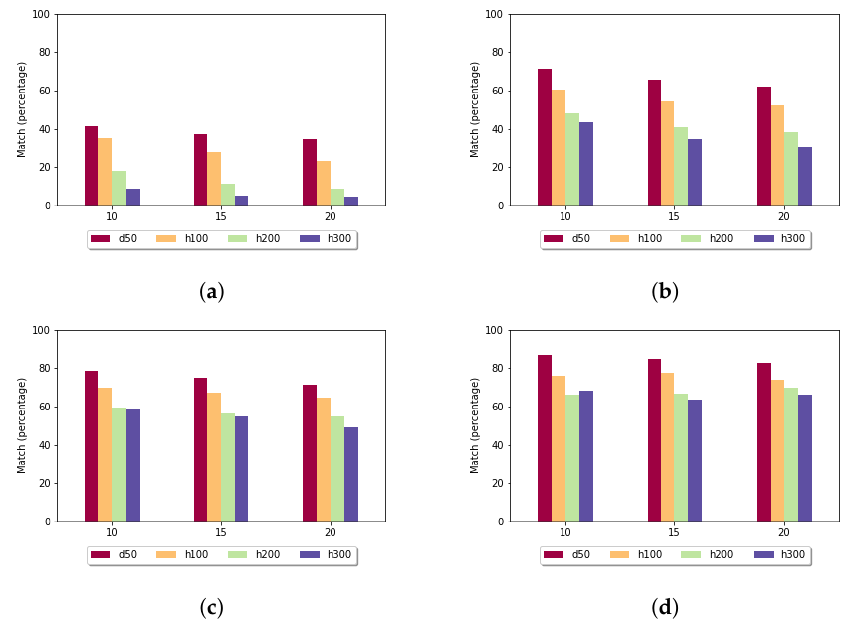
Figure 9. Exact match rate (y axis) depending on the size of the sample set (x axis) and length of the k-mers in the case of fixed gap penalty: ( a ) k = 5; ( b ) k = 7; ( c ) k = 10; and ( d ) k =